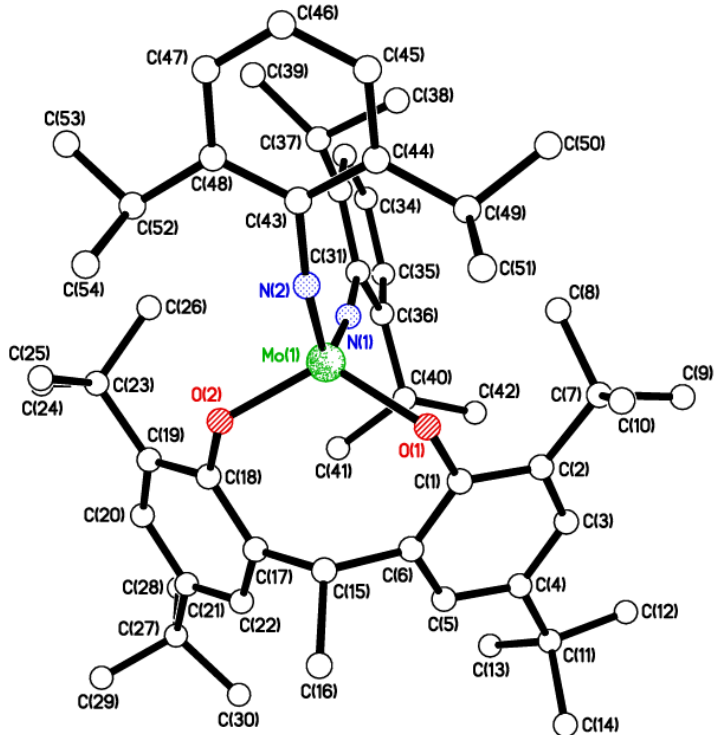
Figure 1. Molecular structure of [Mo(NC 6 H 3 i -Pr 2 -2,6) 2 L 1Me ] ( 1 ), showing the atom numbering scheme. Selected bond lengths (Å) and angles (°): Mo(1)–N(1)